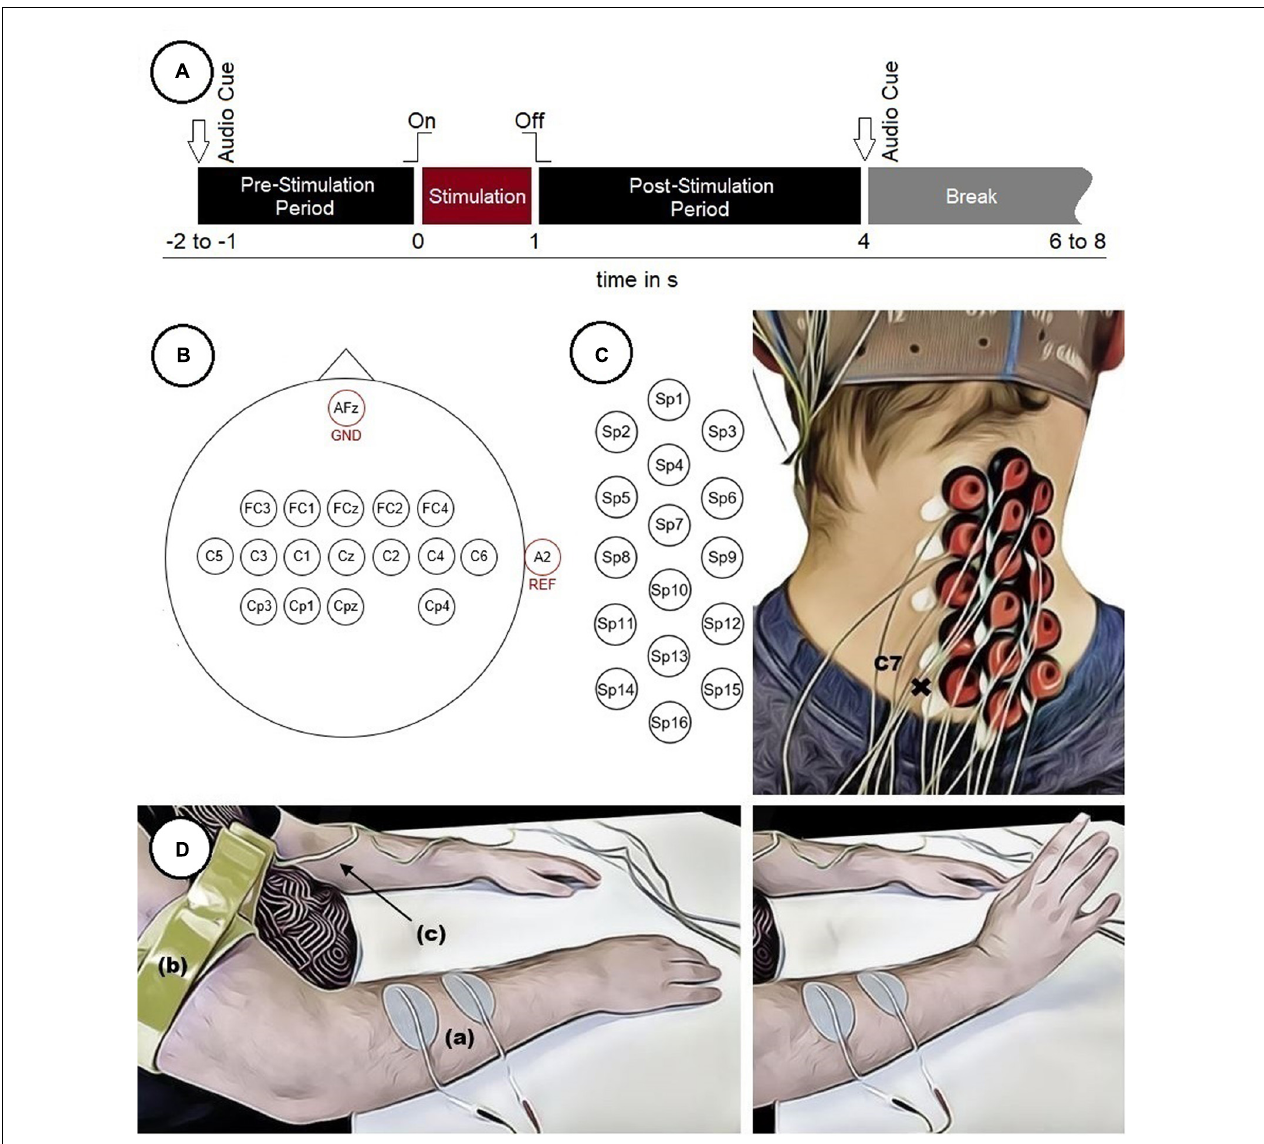
FIGURE 1 | Experimental setup. (A) Timing of a single trial. (B) Electrode positions on the scalp. (C) Electrode positions on the neck used to measure SCPs with marked vertebra C7. (D) Participant with two surface electrodes (a) for electrical stimulation and a limb clamp (b) with potential equalization (c) performing a FES-induced wrist